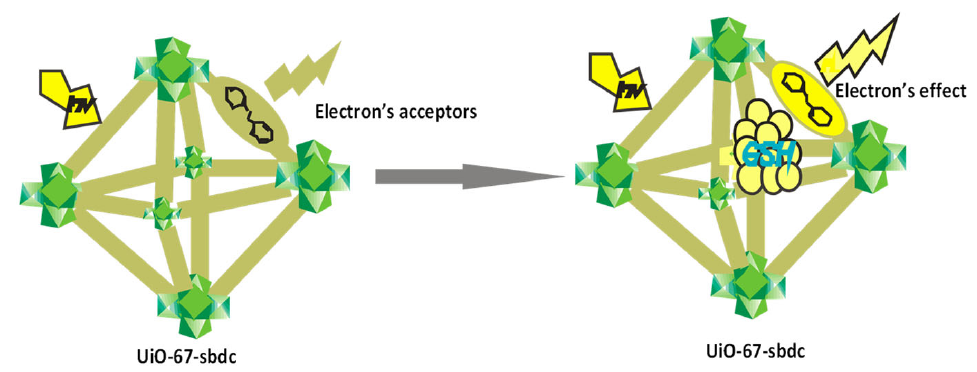
Figure 11. Architecture and proposed mechanism of UiO-67-sbdc to